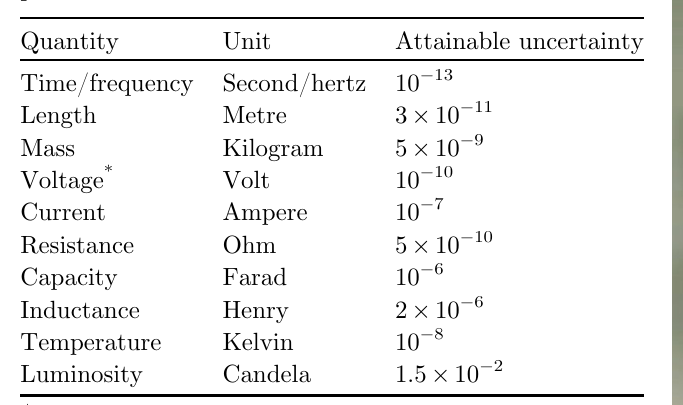
Table 3. Best accuracies today attainable for main parameters.